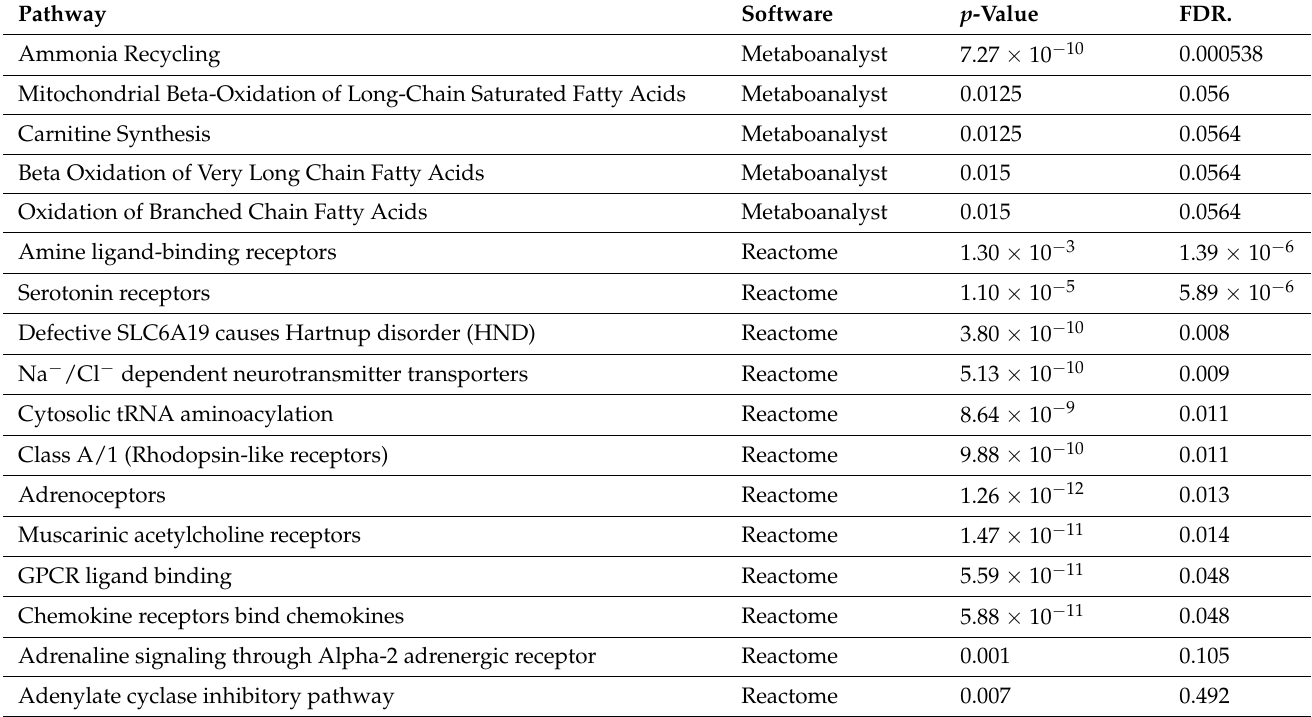
Table 3. Metabolic pathway analysis: pathway discriminating early and advanced ALS patients. For each pathway is reported p -value, FDR